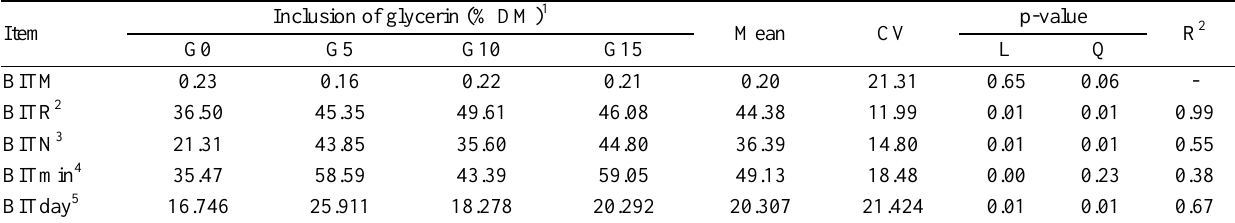
Table 4. Influence of addition of glycerin levels on the bite traits in supplemented heifers on a Brachiaria brizantha pasture